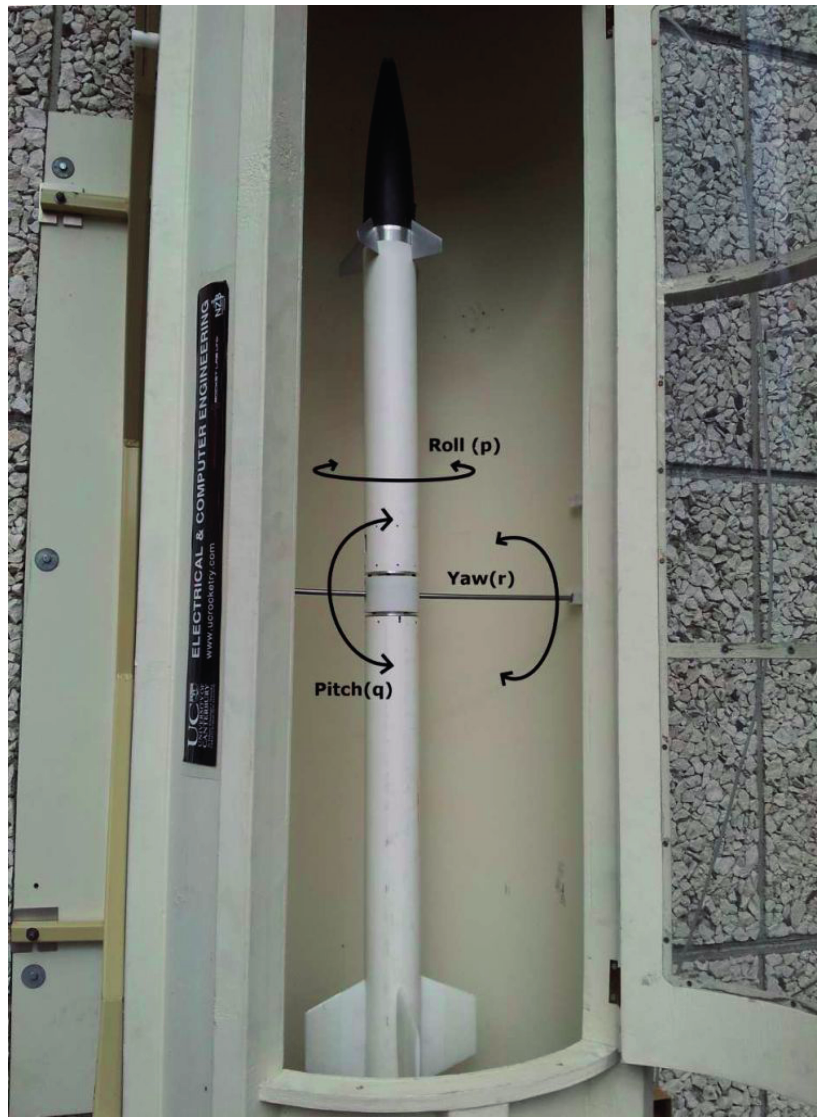
Figure 9. Gimbal frame set up in wind